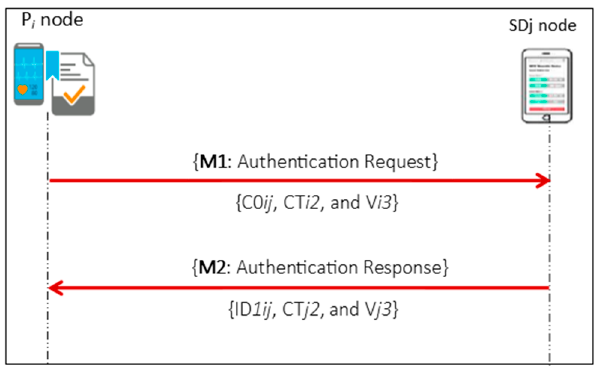
Figure 3. Short-term authentication phase (SAP).